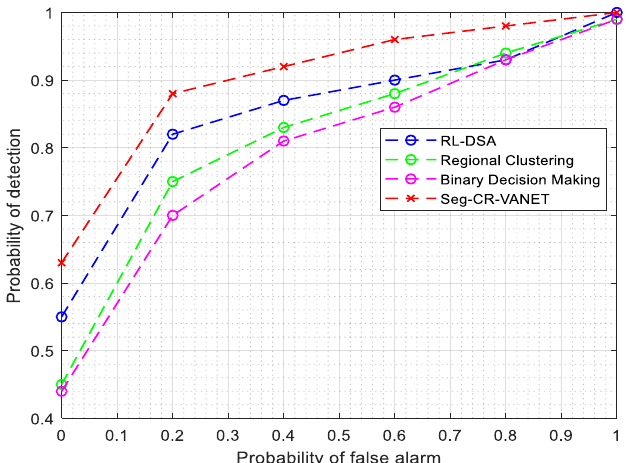
Figure 8. ROC curves of proposed solution and prior works.